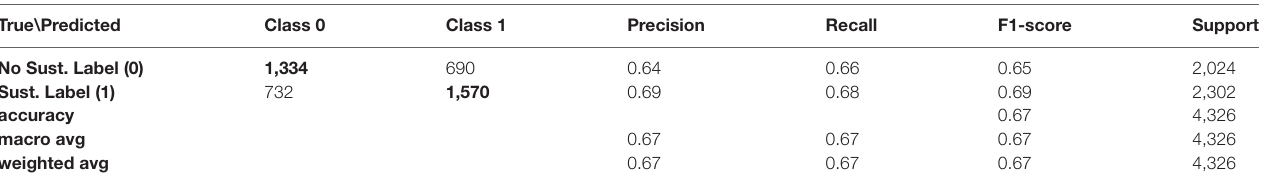
TABLE 4 | Model performance parameters.